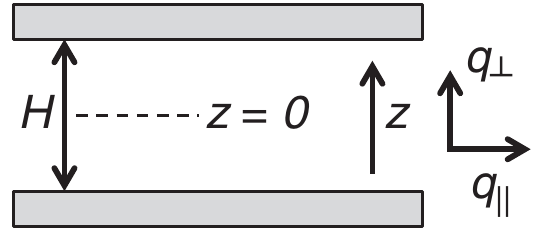
FIG. 1. Schematic of the confinement geometry. The surface separation is denoted by H , the z axis is aligned perpendicularly to the confining surfaces, and the center of the slit is positioned at z ¼ 0 . The scattering vector components parallel ( q ∥ ; in plane) and perpendicular ( q ⊥ ; out of plane) to the confining surfaces are also